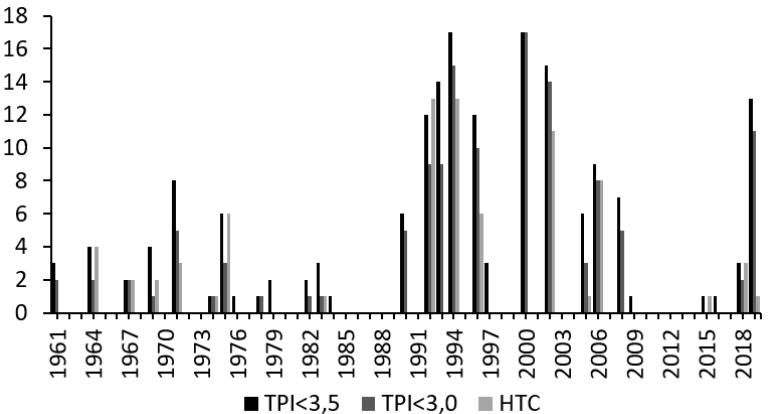
Fig. 8. Number of meteorological stations in Lithuania where droughts were recorded in 1961–2019 according to TPI < 3.5, TPI < 3.0 and HTC